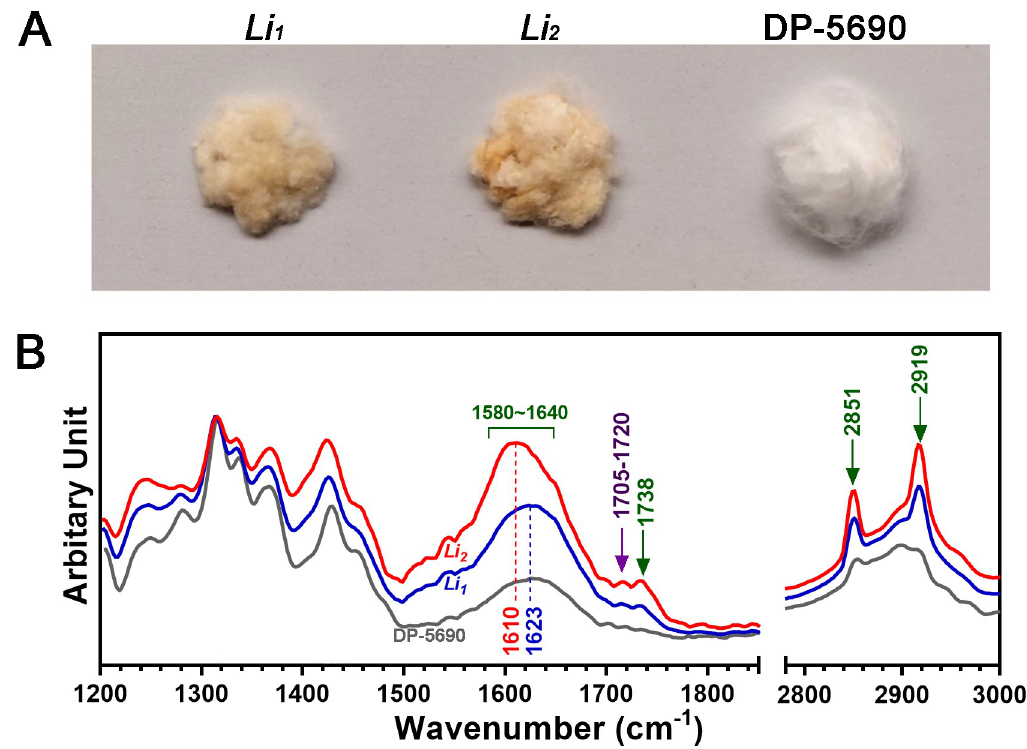
Fig 5. Suberin and lignin deposition in the polyploid G . hirsutum Li 1 and Li 2 mutant fibers among the 2 nd set of cotton materials. A. Color detection from the developed Li wavenumbers representing suberin and lignin were described with green and purple fonts, respectively.